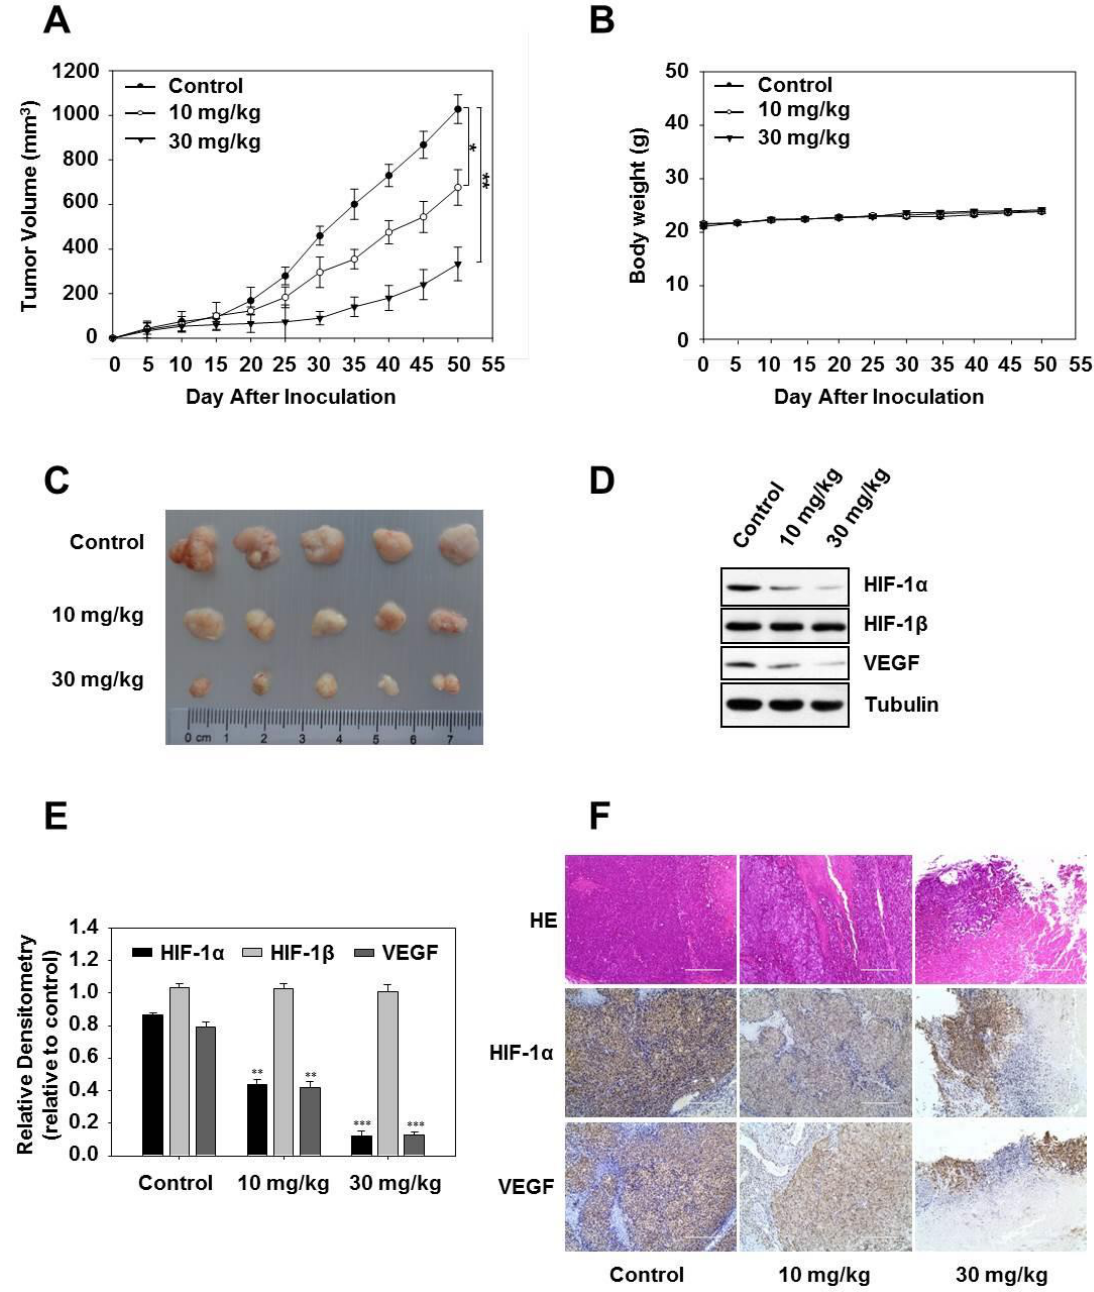
Figure 7. Vanillic acid inhibits tumor growth in a human tumor model. ( A ) and ( B ) HCT-116 cells were implanted subcutaneous injection (s.c) in the left flanks of nude mice, which were administered per oral (p.o) three times a week with vehicle ( n = 5), vanillic acid (Van, 10 mg/kg, n = 5) or vanillic acid (Van, 30 mg/kg, n = 5) starting from day five. Tumor volume and mouse weight were measured using an equation and a digital balance, respectively, every five days. ( C ) Representative tumor masses of 3 groups, which were harvested 4 h after the last treatment, and the isolated tumors were photographed. ( D ) Western blot analysis of HIF-1 α , HIF-1 β , and VEGF in tumor blocks is shown. Tubulin was used as a loading control. ( E ) Data are shown as mean ± SD ( n = 3). ** p < 0.01, *** p < 0.001, compared with hypoxia control. ( F ) Tumor sections were stained with hematoxylin and eosin and analyzed by immunohistochemistry for HIF-1 α and VEGF. Original magnification, 200 ×. 2.8. Diagram of the Proposed Mechanism by which Vanillic Acid Inhibits Cell Proliferation and Angiogenesis